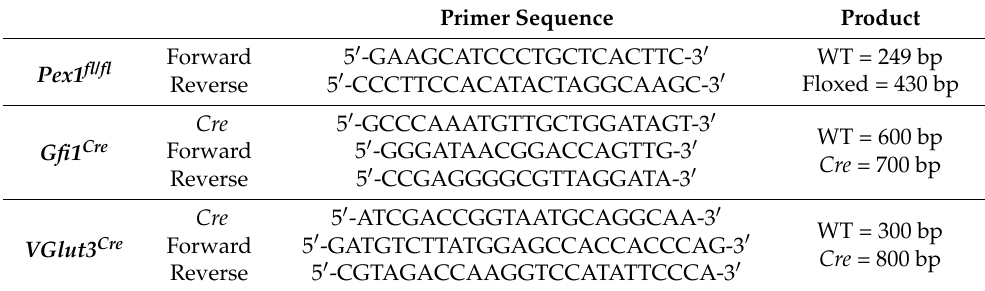
Table 1. Primer sets used for